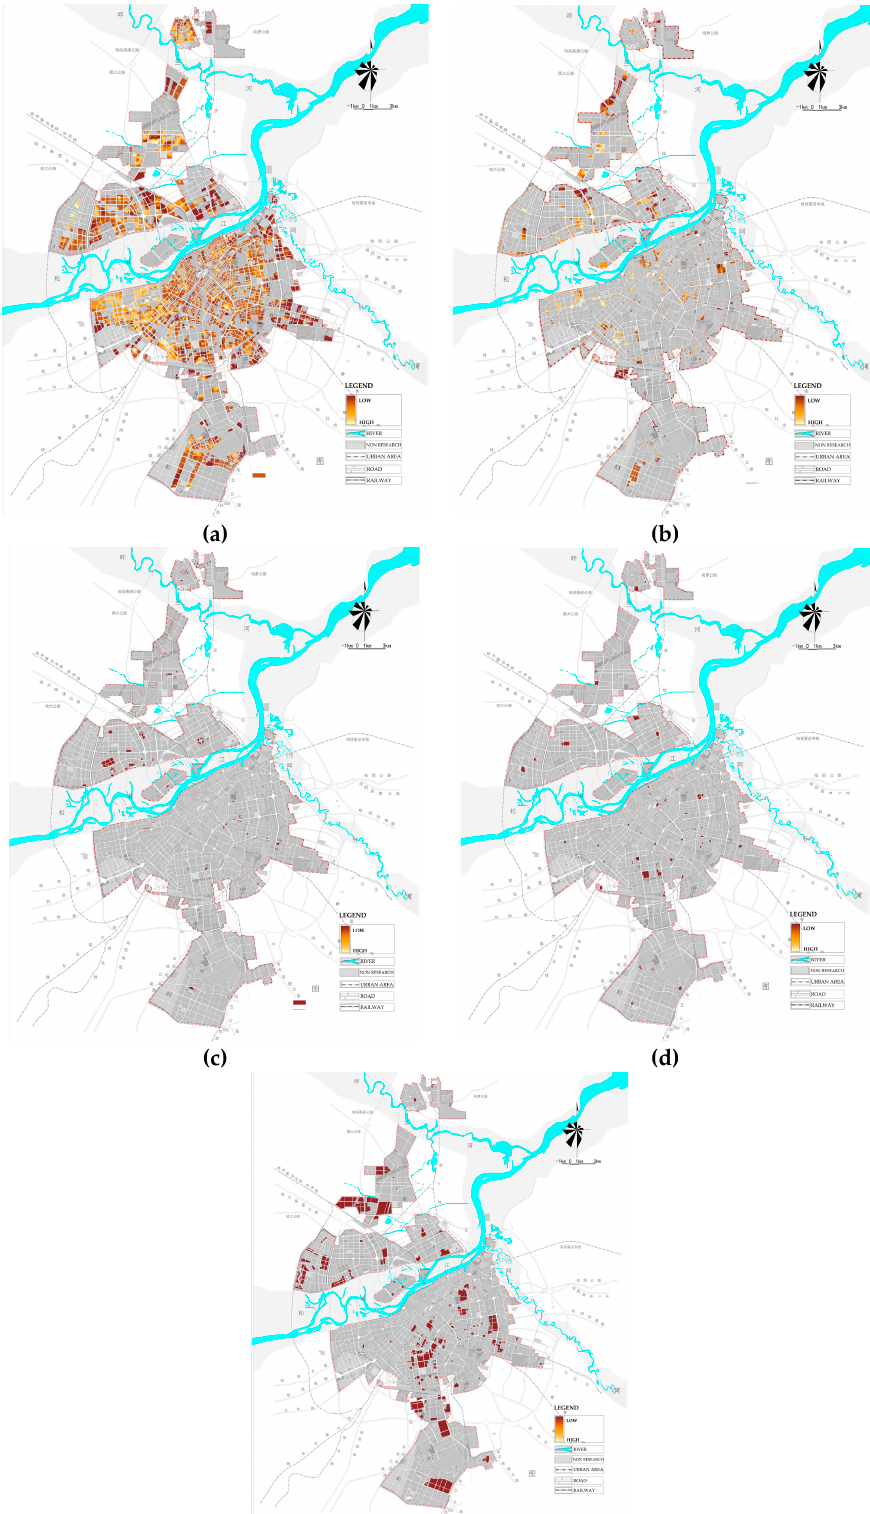
Figure 12. Annual energy conservation of different types of land. ( a ) Residential land; ( b ) commercial land; ( c ) office land; ( d ) medical land; ( e ) educational